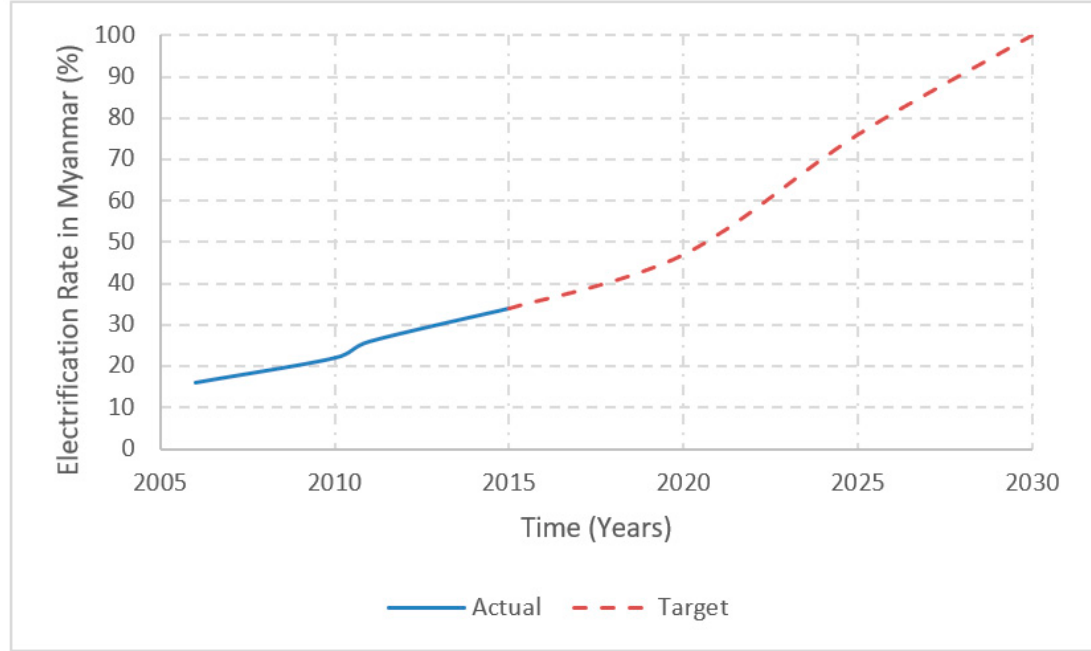
Figure 4. Electrification rate in Myanmar [36].